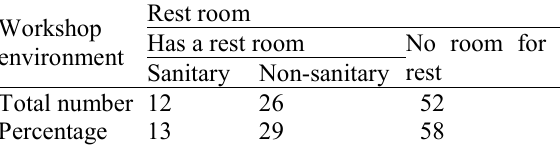
Fig. 1. Status of healthcare facilities Table 3. Restroom of workers